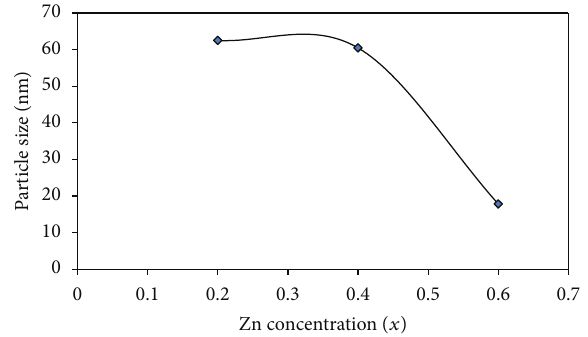
Figure 2: Variation of particle size with Zn in